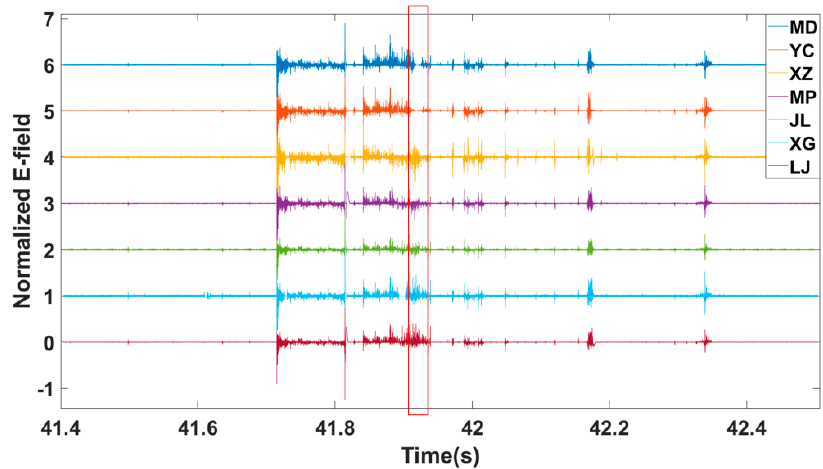
Figure 14. Normalized electric field signal over time from the seven stations for CG flash